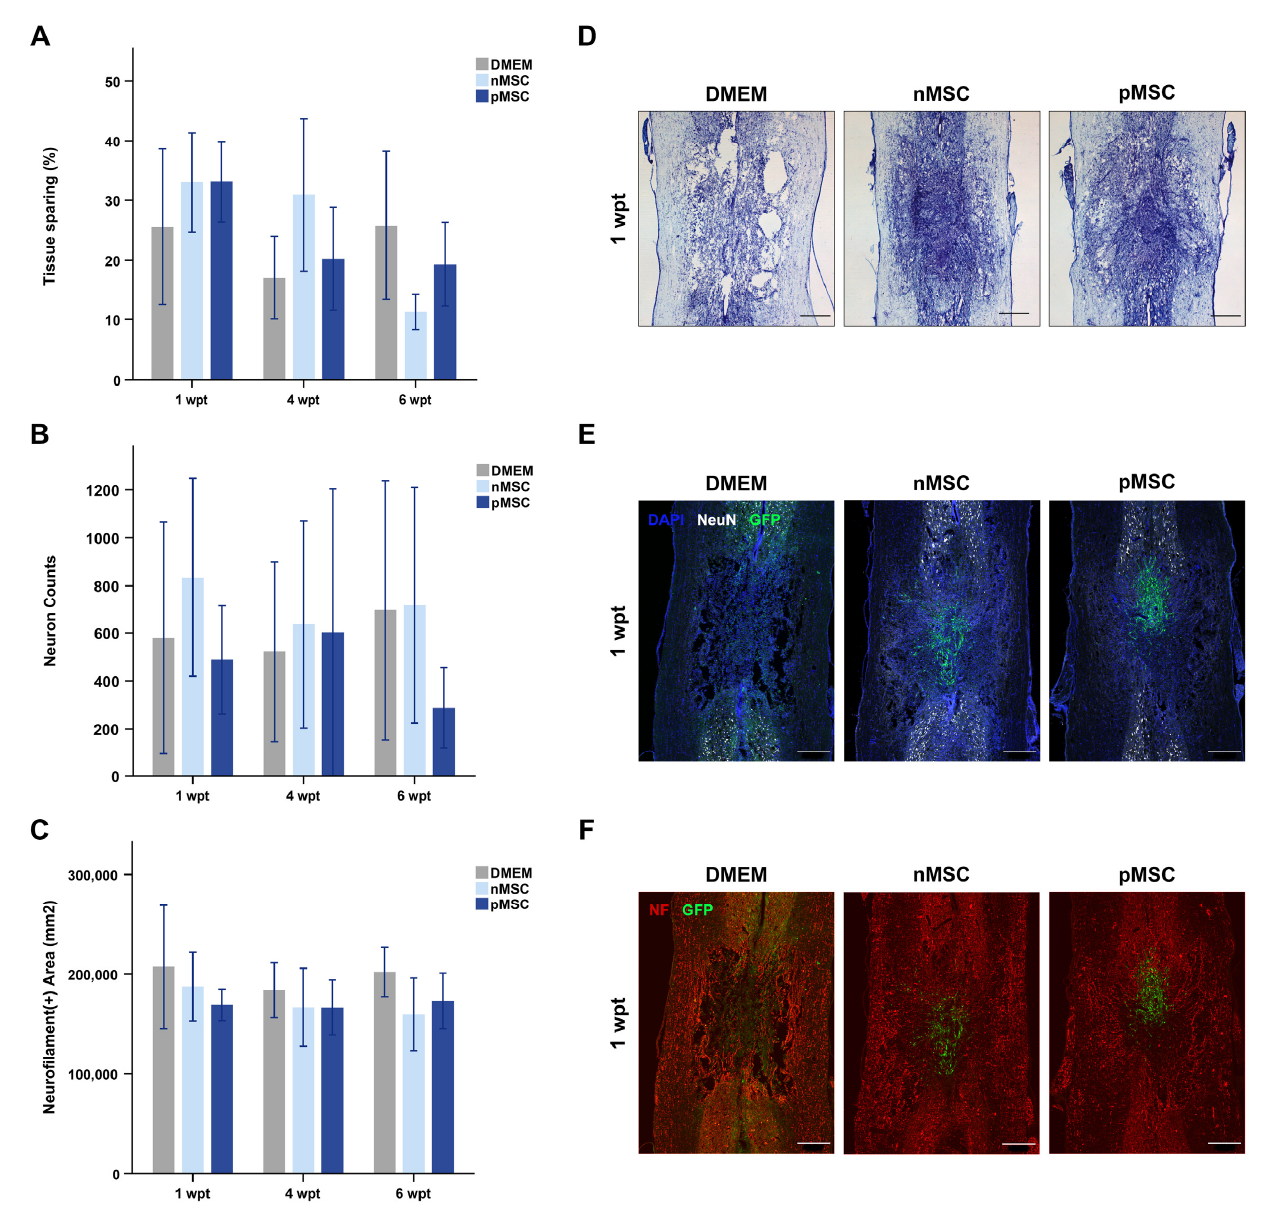
Figure 3. All experimental groups have similar effects on nervous tissue sparing. ( A ) Bar graph representing the percentage of healthy tissue spared, relative to an equally sized healthy spinal cord segment over time. No significant differences were found between groups. ( B ) Bar graph representing the number of neurons present just rostral and caudal to the injury over time. No significant differences were found between groups. ( C ) Bar graph representing axonal presence in the injury over time. No significant differences were found between groups. On ( A – C ), bars represent the mean and SEM. n = 6 per group and time point. ( D – F ) Example photomicrographs of injured spinal cords at 1 wpt are shown for visualization purposes. The spinal cords’ orientation is top–rostral and bottom–caudal. ( D) Tissue sparing was quantified using cresyl violet staining imaged under a bright field microscope (2.5 × magnification). ( E ) Neuronal bodies were quantified using NeuN (white), GFP (green), and DAPI (blue) staining. ( F ) Axonal presence was quantified using NF (red) and GFP (green) staining. For ( E , F ), intensity was equally modified on all images for illustrative purposes only but not for quantitative analysis (Overview: 4 × , image scan: 20 × ). Any green fluorescence detected on the DMEM images on E and F is product of auto fluorescence since those animals did not receive LV-GFP transduced cells. Scale bars on all images represent 500 µ m. Abbreviations: DMEM: Dubbelco’s Modified Eagle’s Medium; nMSC: naïve MSC; pMSC: primed MSC; wpt: weeks post-transplant; GFP: green fluorescent protein; MSC: mesenchymal stromal cell; NeuN: neuronal nuclei; NF: